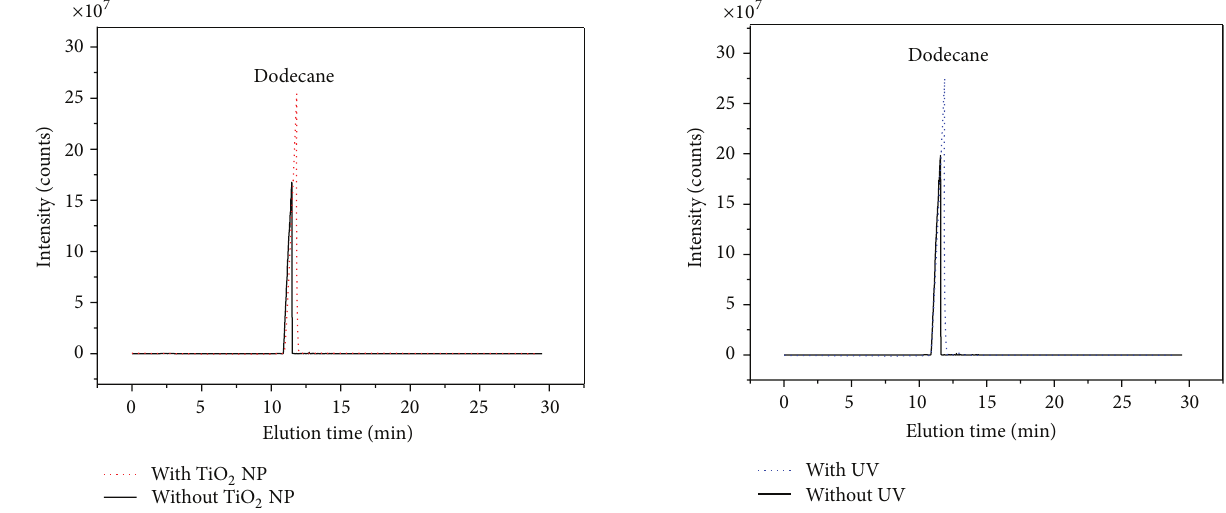
Figure 9: Chromatograms obtained by GC-MS for UV-A-irradiated dodecane-loaded polyamide microcapsules in the presence and absence of N-doped TiO 2 nanoparticles (NP700).